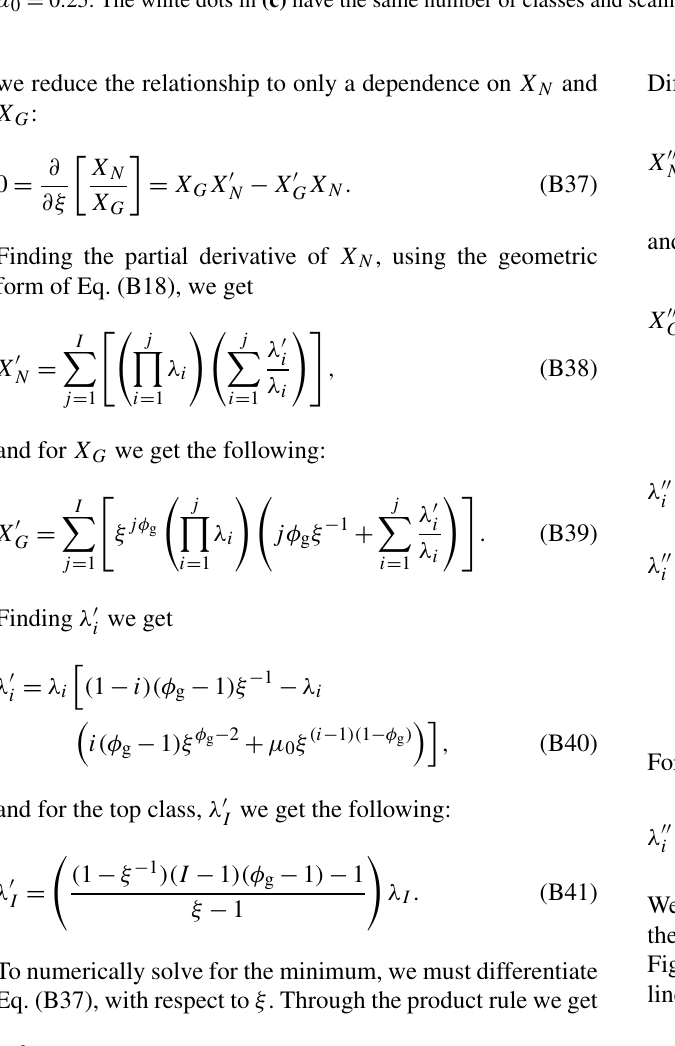
Figure B2. Comparison of the discretized model to the continuum analytical solution, showing convergence for higher numbers of mass classes. This example uses parameters for broadleaf evergreen tropical trees (BET-Tr PFT) with α = 0 . 1: (a) equilibrium coverage ν eq versus µ 0 for the exact continuum solution (black line) and discretizations of the mass dimension with varying numbers of mass classes and mass class width scaling ( ξ ); (b) absolute error in the modelled value of ν eq against the number of mass classes using the optimum value of ξ for each case; (c) optimum ξ versus number of mass classes, with contours showing the absolute error in ν eq . Panels (b) and (c) assume µ 0 = 0 . 25. The white dots in (c) have the same number of classes and scaling as the discrete lines in (a)